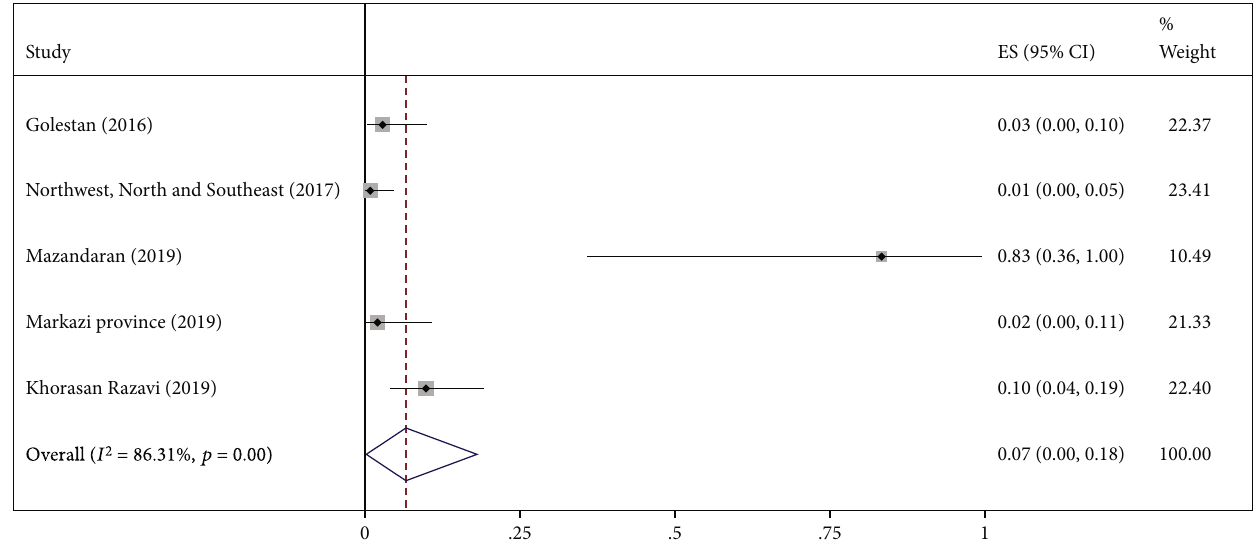
Figure 5: Forest plot of 5 studies on cystic echinococcosis G